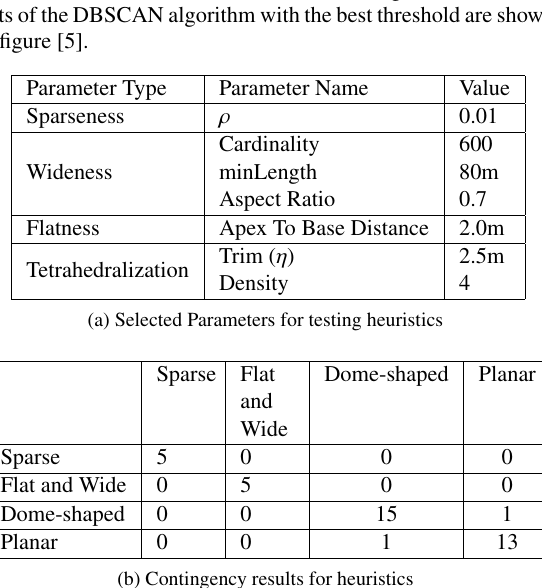
Table 1: Parameters and contingency tables for testing heuristical data processing